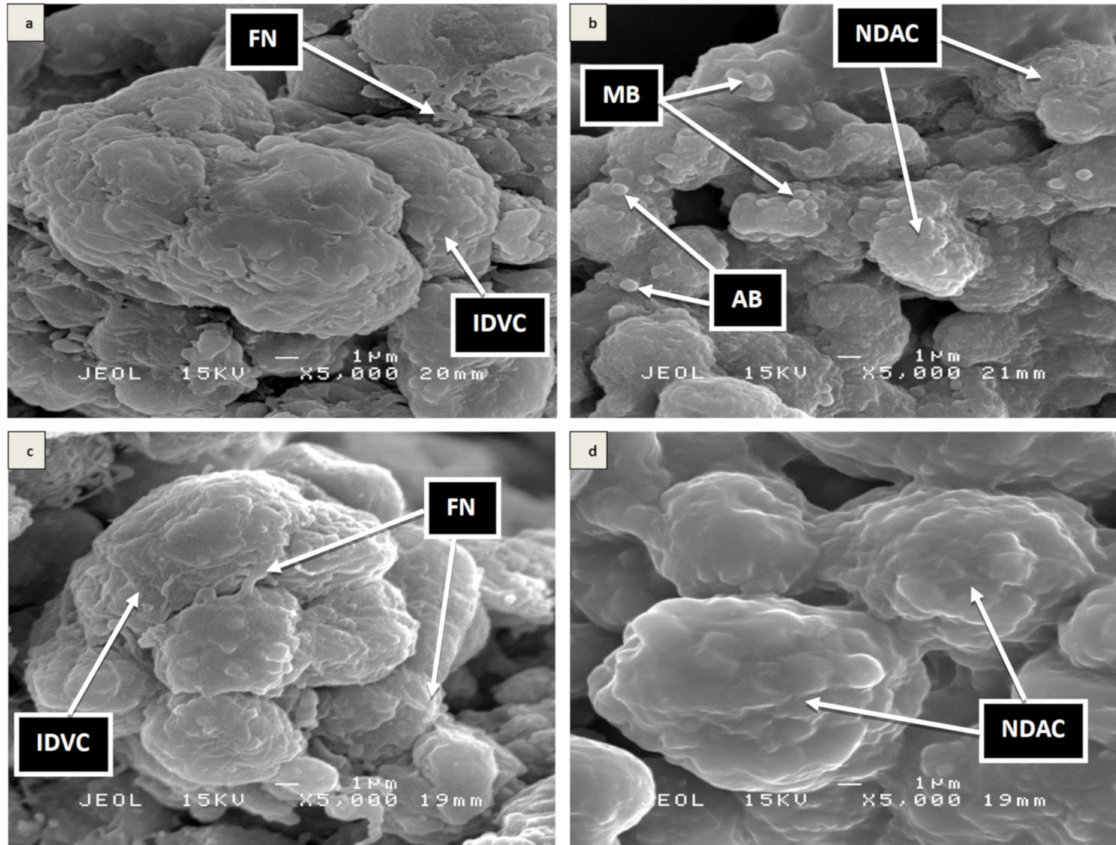
Figure 6. Surface morphological analysis of the differentiated SH-SY5Y cells by scanning electron microscopy. ( a ) Untreated differentiated SH-SY5Y cells, ( b) 24 h H 2 O 2 -challenged cells, ( c ) 48 h Kefir B pre-treated plus 24 h H 2 O 2 -exposed cells, and ( d ) 48 h Kefir C pre-treated plus 24 h H 2 O 2 -exposed cells. FN = folded neurites, IDVC = intact differentiated viable cells, NDAC = neurite disrupted apoptotic cells, AB = apoptotic body, MB = membrane blebbing. Magnification (x